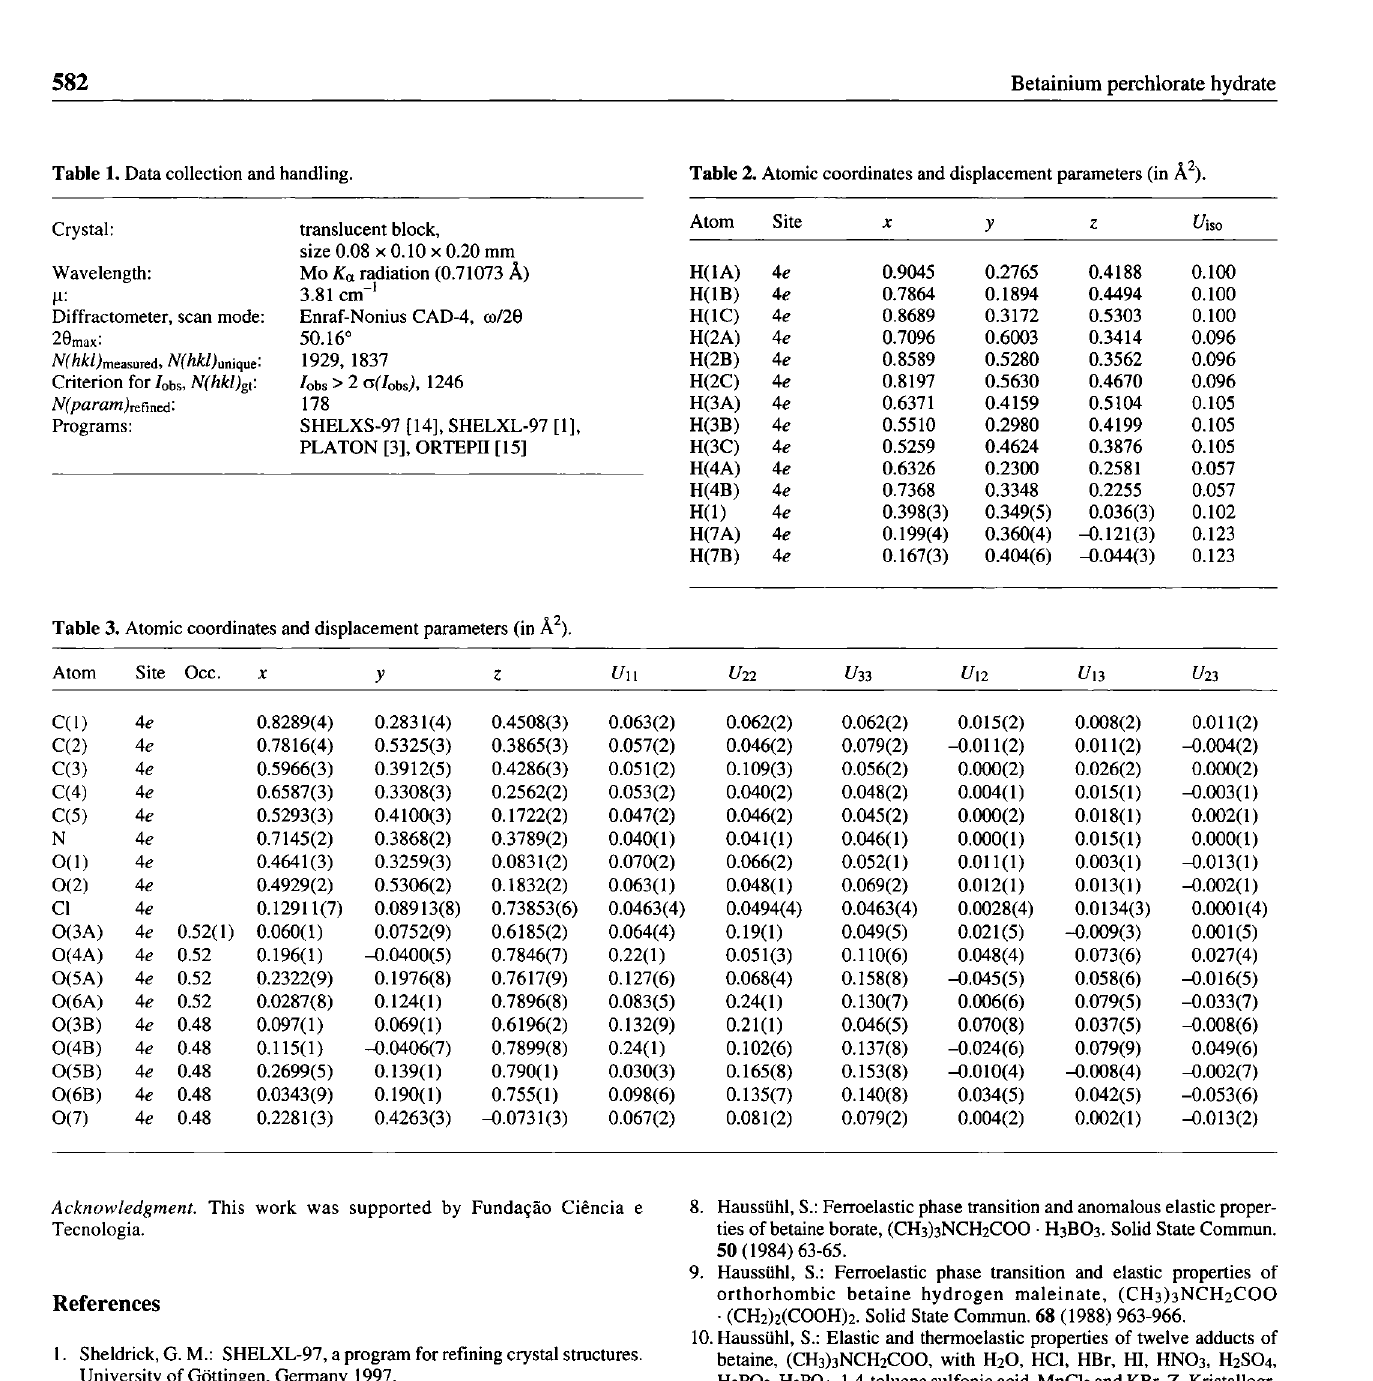
Table 1. Data collection and handling. Table 2. Atomic coordinates and displacement parameters (in Â 2 ).